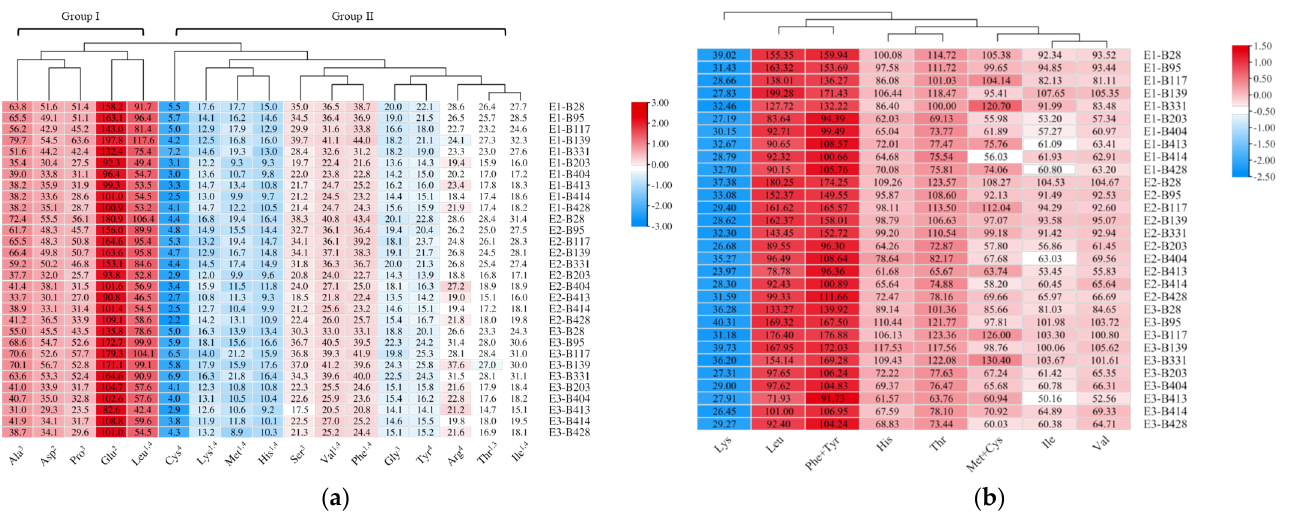
Figure 4. Clustering of amino acid content (mg · g − 1 ) ( a ) and amino acid scores ( AAS , %) of essential amino acids ( b ) in foxtail millet of 10 foxtail millet varieties in E1, E2 and E3. The 10 accessions include 5 accessions (B28, B95, B139, B117 and B331) with high protein content (>12%) and another 5 accessions (B203, BB404, B428, B414 and B413) with low protein content in foxtail millet grains. The amino acids, marked with “1” are essential amino acids ( EAA ), with “2” are fresh amino acids, with “3” are sweet amino acids, with “4” are bitter amino acids.